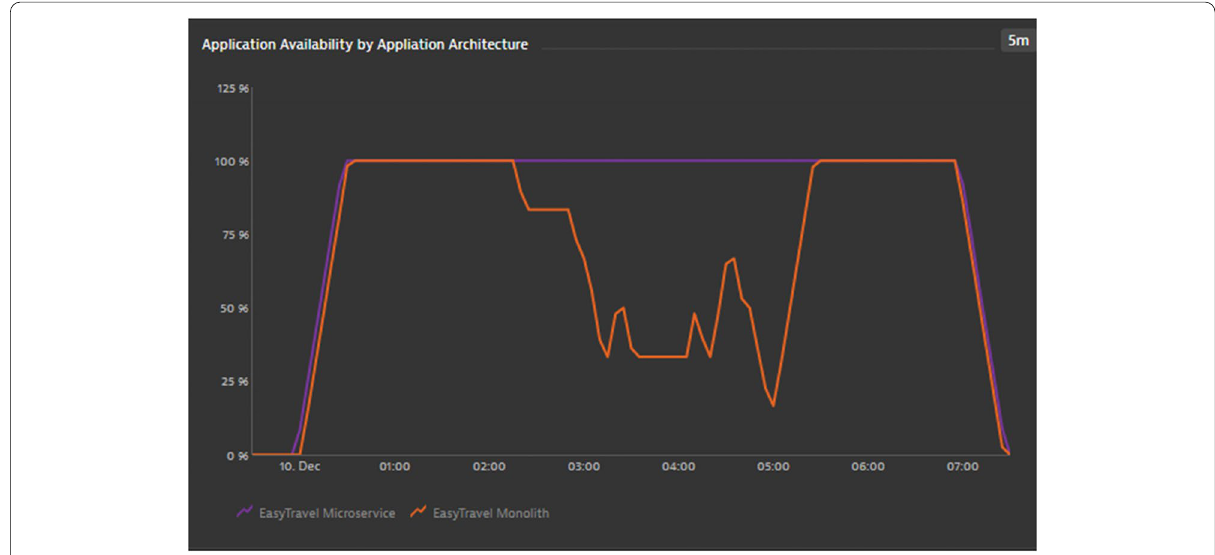
Fig. 21 Application availability (split by application architecture)